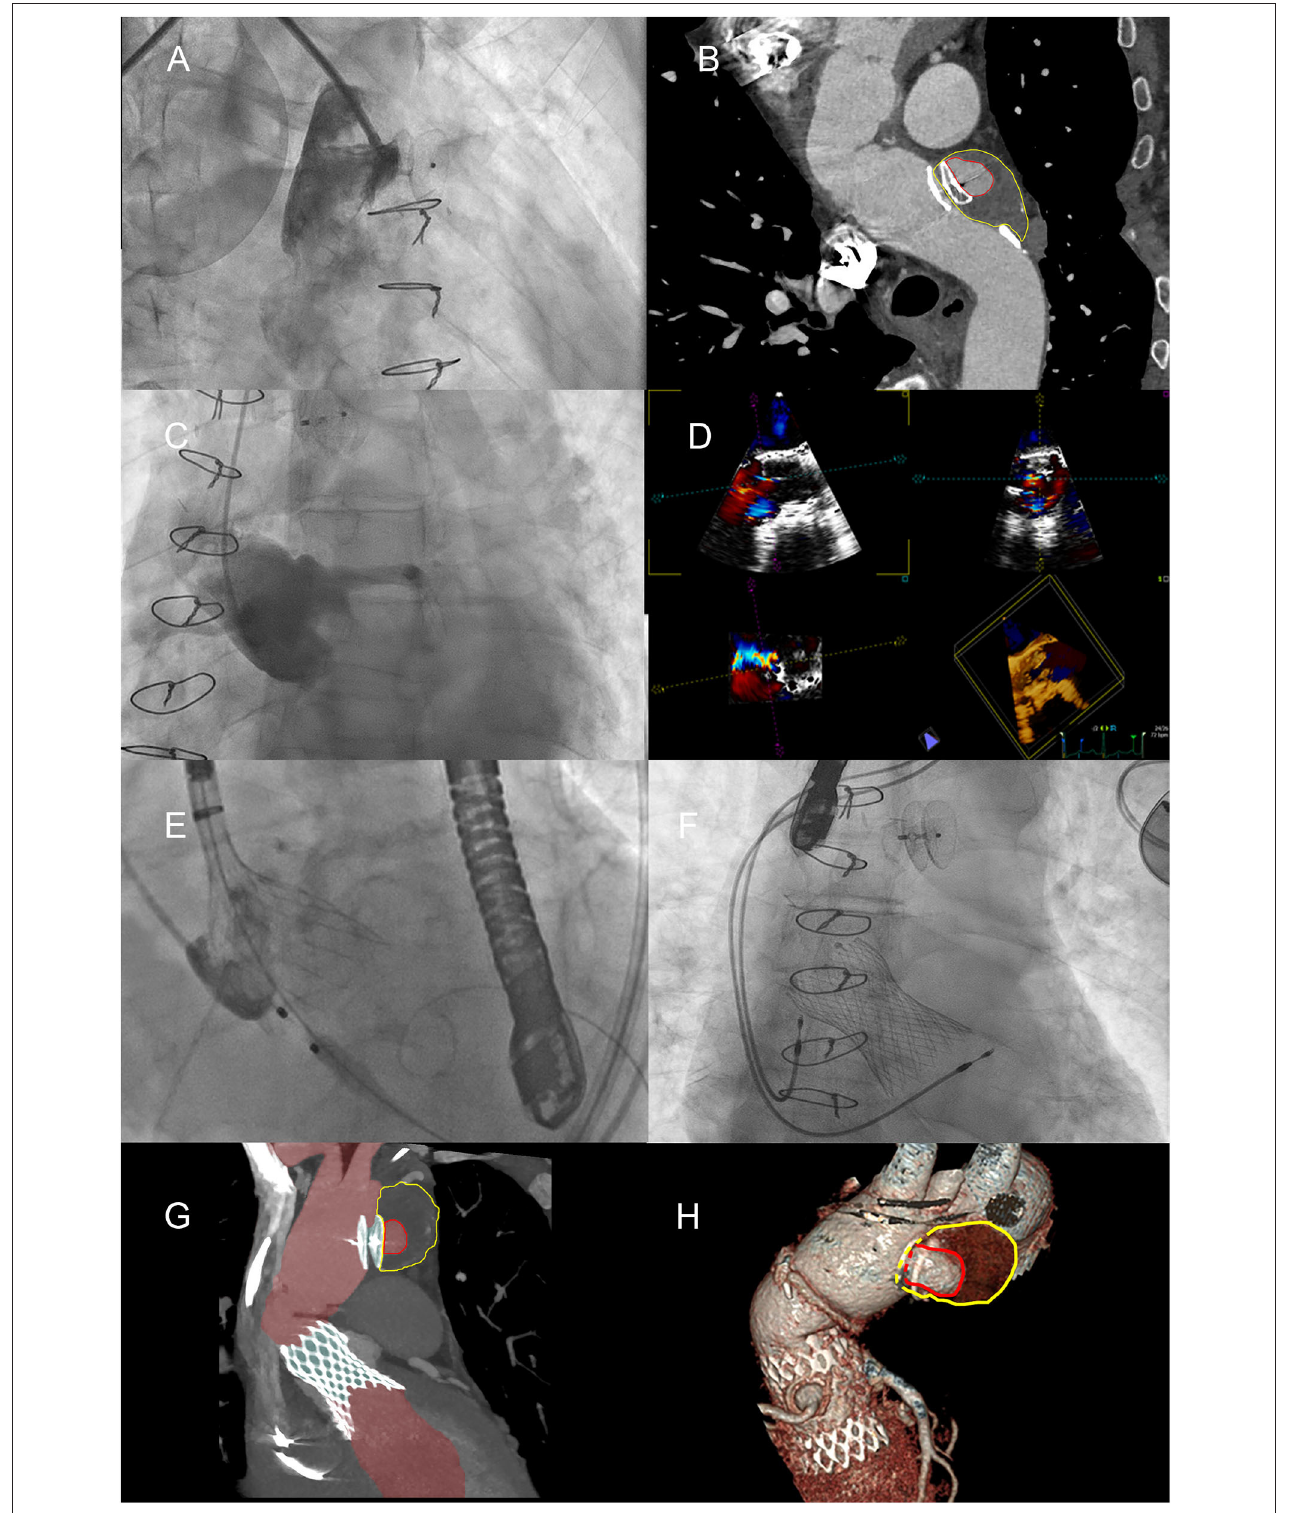
FIGURE 3 | Positioning of the Amplatzer device and the Medtronic valve. (A) Positioning of the Amplatzer device, with angiography demonstrating the apparent total obliteration of the AAP. (B) MPR curved reconstruction of angio-CT, 1 month after placing the Amplatzer device. The red line highlights the perfused part of the